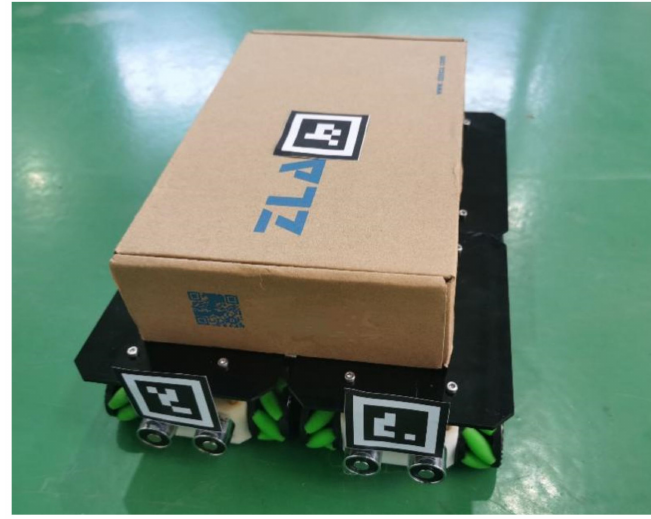
Figure 26. Carrying objects larger than a